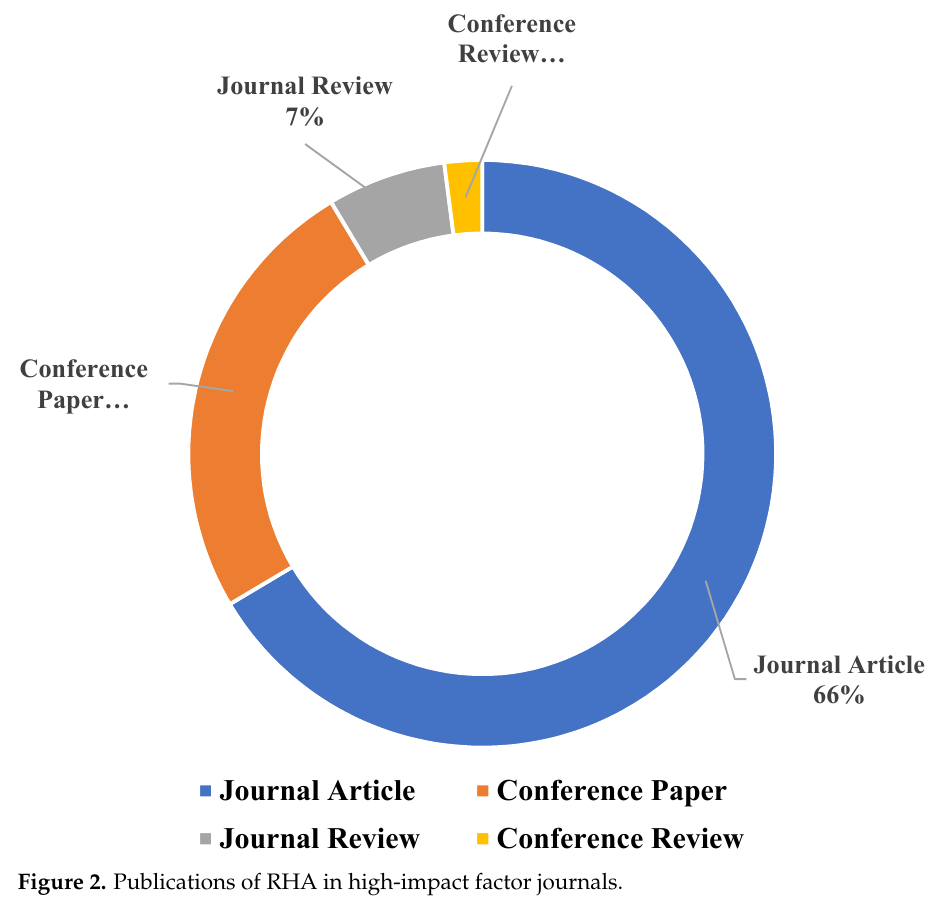
Figure 2. Publications of RHA in high-impact factor journals.